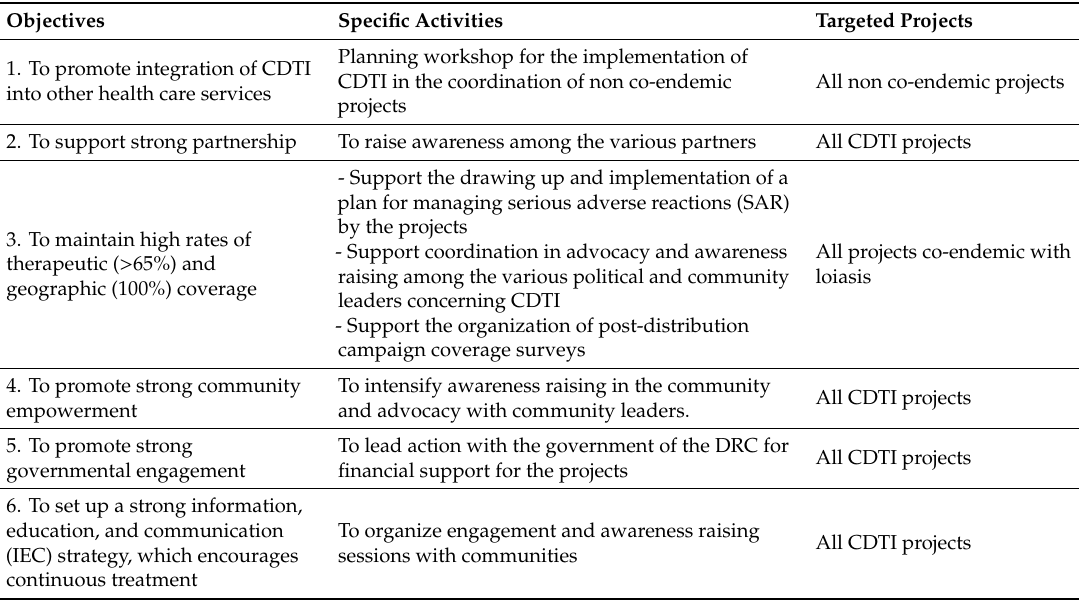
Table 4. Activities encouraging long-term compliance with CDTI in the